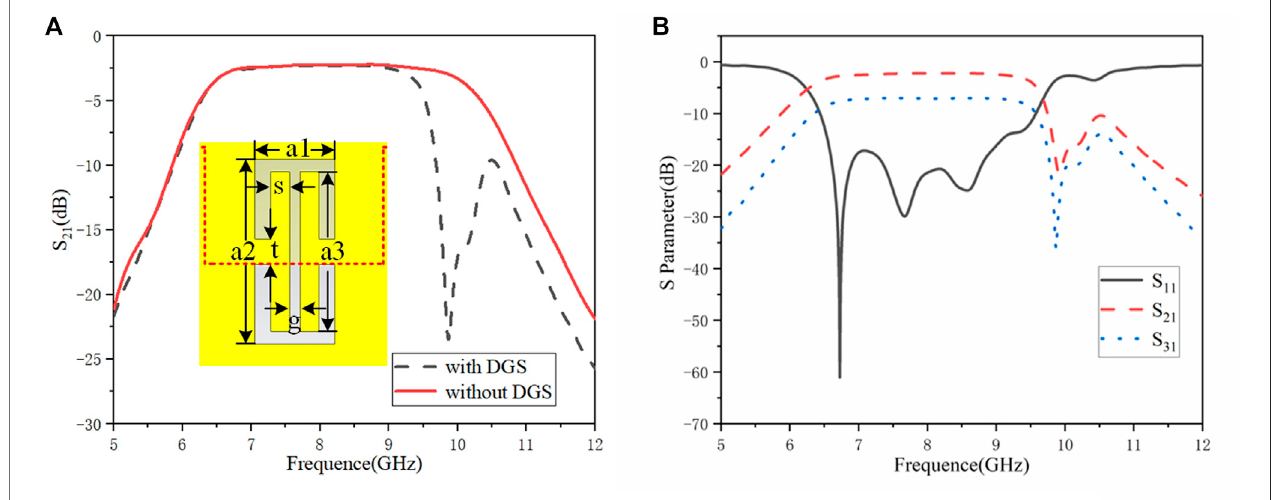
FIGURE 6 | (A) the comparison of S 21 of the designs with and without DGSs. (B ) Simulated S-parameters of the design with DGS.